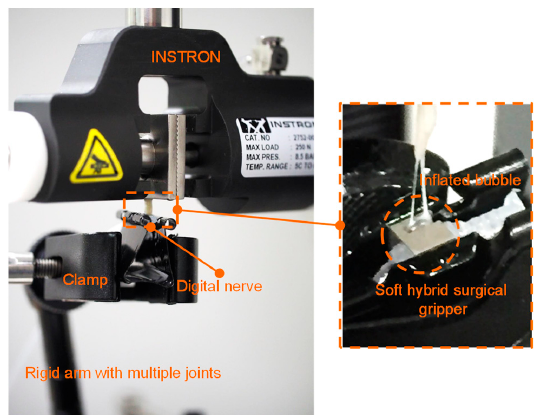
Figure 10. The experimental setup for measuring the pulling force based on the soft hybrid surgical gripper.